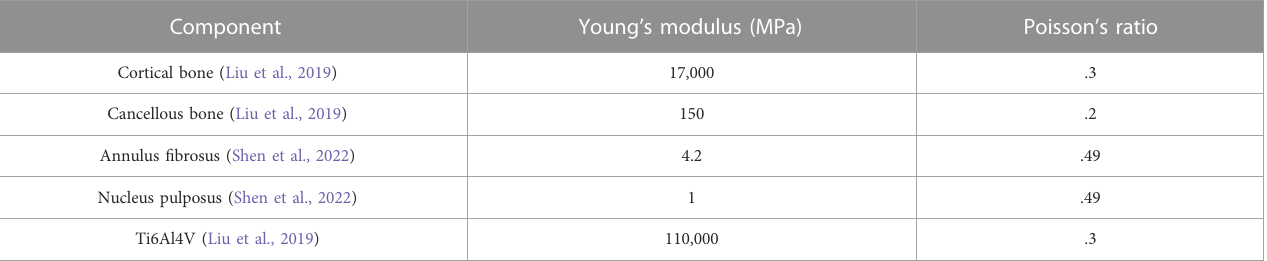
TABLE 2 The material characteristics of various